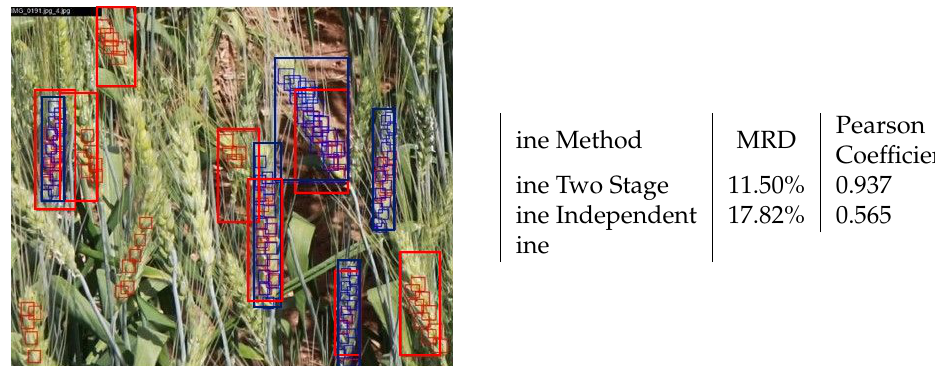
Figure 5. Left: Ground truth (blue) and predicted (red) bounding boxes for spikes and spikelets, detected independently. The lack of object-part correspondence is clearly visible. Right: Accuracy comparison between the two-stage and the independent detection methods. The Pearson coefficient is computed between the two mean count estimators and the ground truth mean.